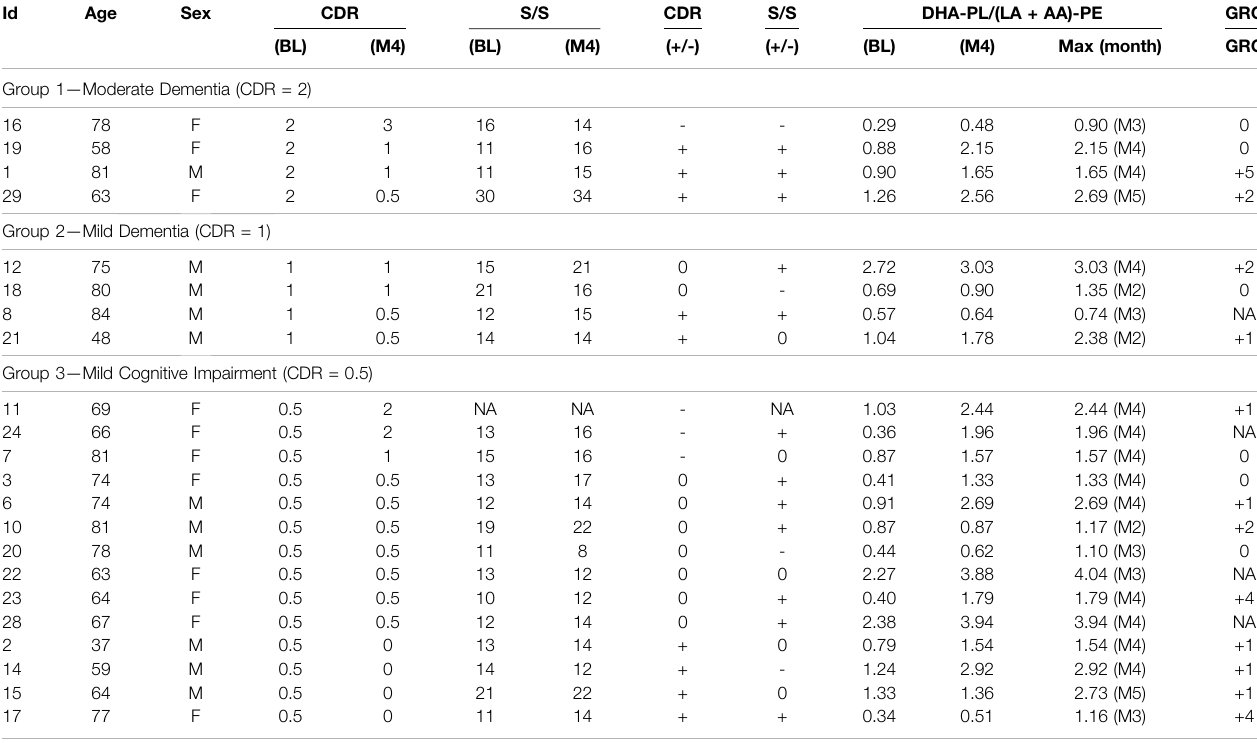
TABLE 4 | Individual participant demographics and clinical responses.